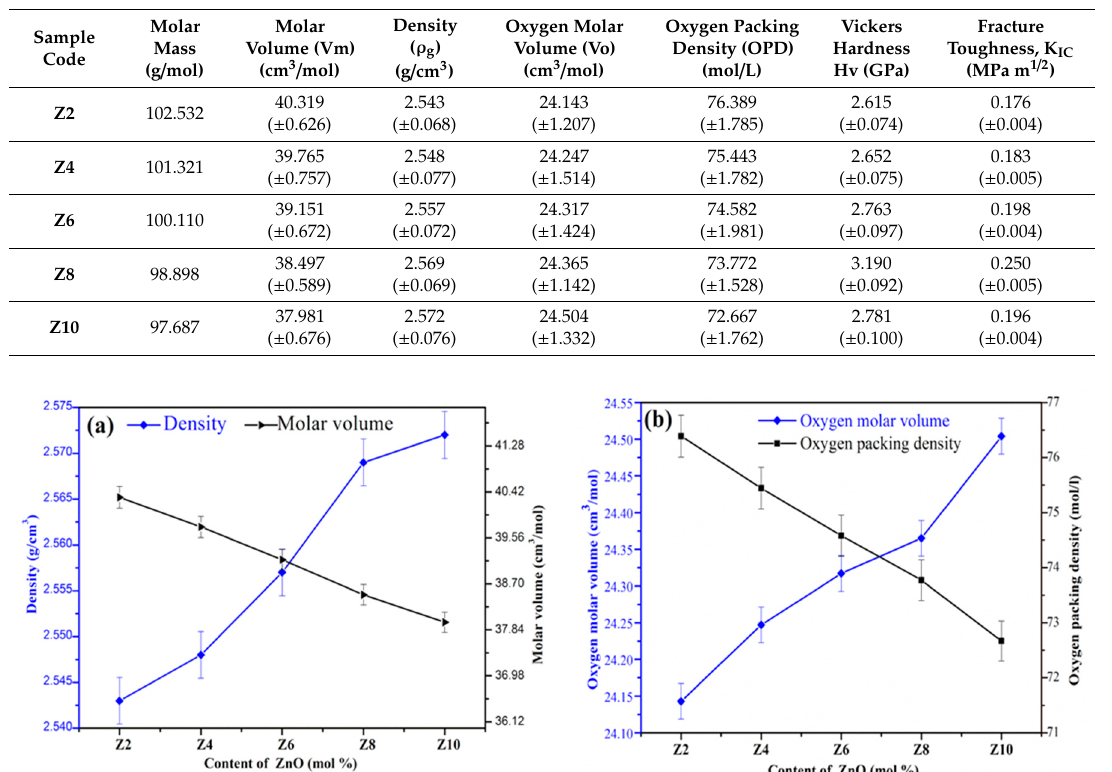
Figure 1. Variability of distinct physical parameters of glasses investigation with the increase in content of ZnO (mol%): ( a ) Density (g / cm 3 ) and molar volume ( b ) Oxygen packing density and Oxygen molar volume. Table 2. Physical parameters of the ZnO–Na 2 O–CaO–P 2 O 5 glass system.